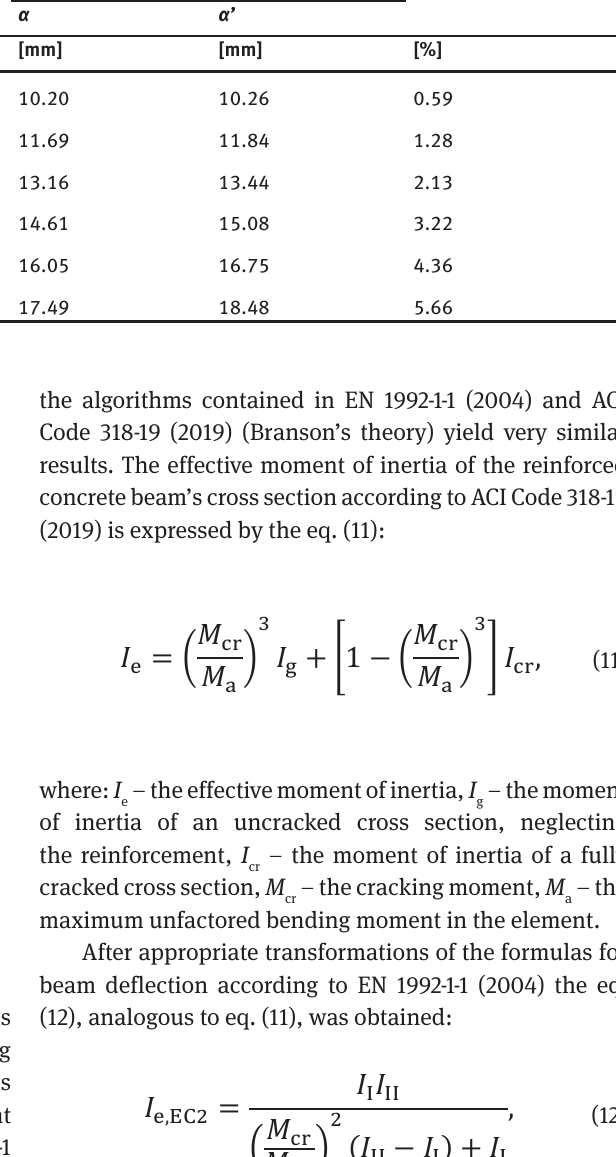
Table 2: Comparison of beam deflections for constant and variable Young’s modulus of concrete.